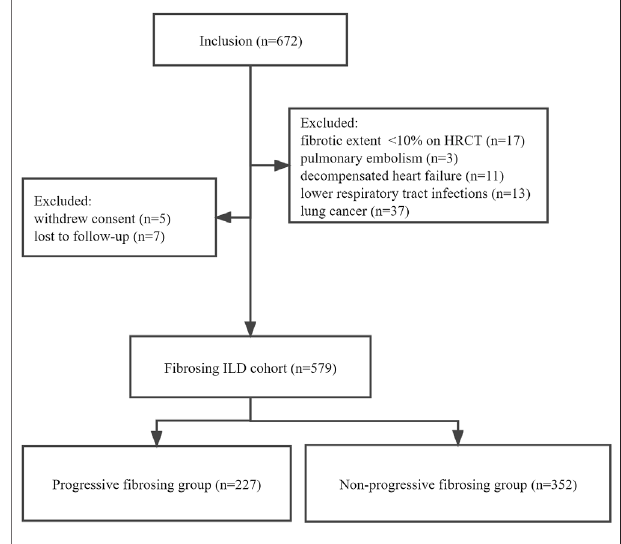
FIGURE 1 | Patient fl owchart. ILD, interstitial lung disease; PFT, pulmonary function test; HRCT, high-resolution computed